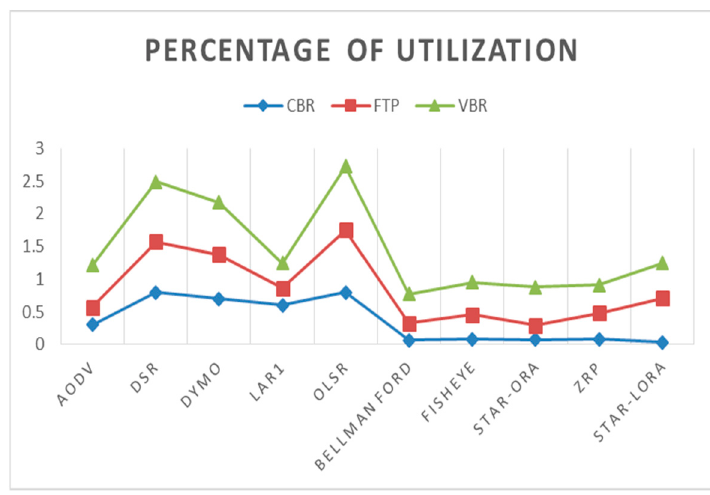
Figure 19. Percentage of utilization of all routing protocols for 120 nodes.